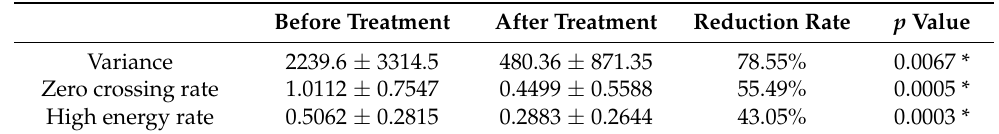
Table 3. Comparison of variance, zero-crossing rate, and high energy rate values before and after treatment.